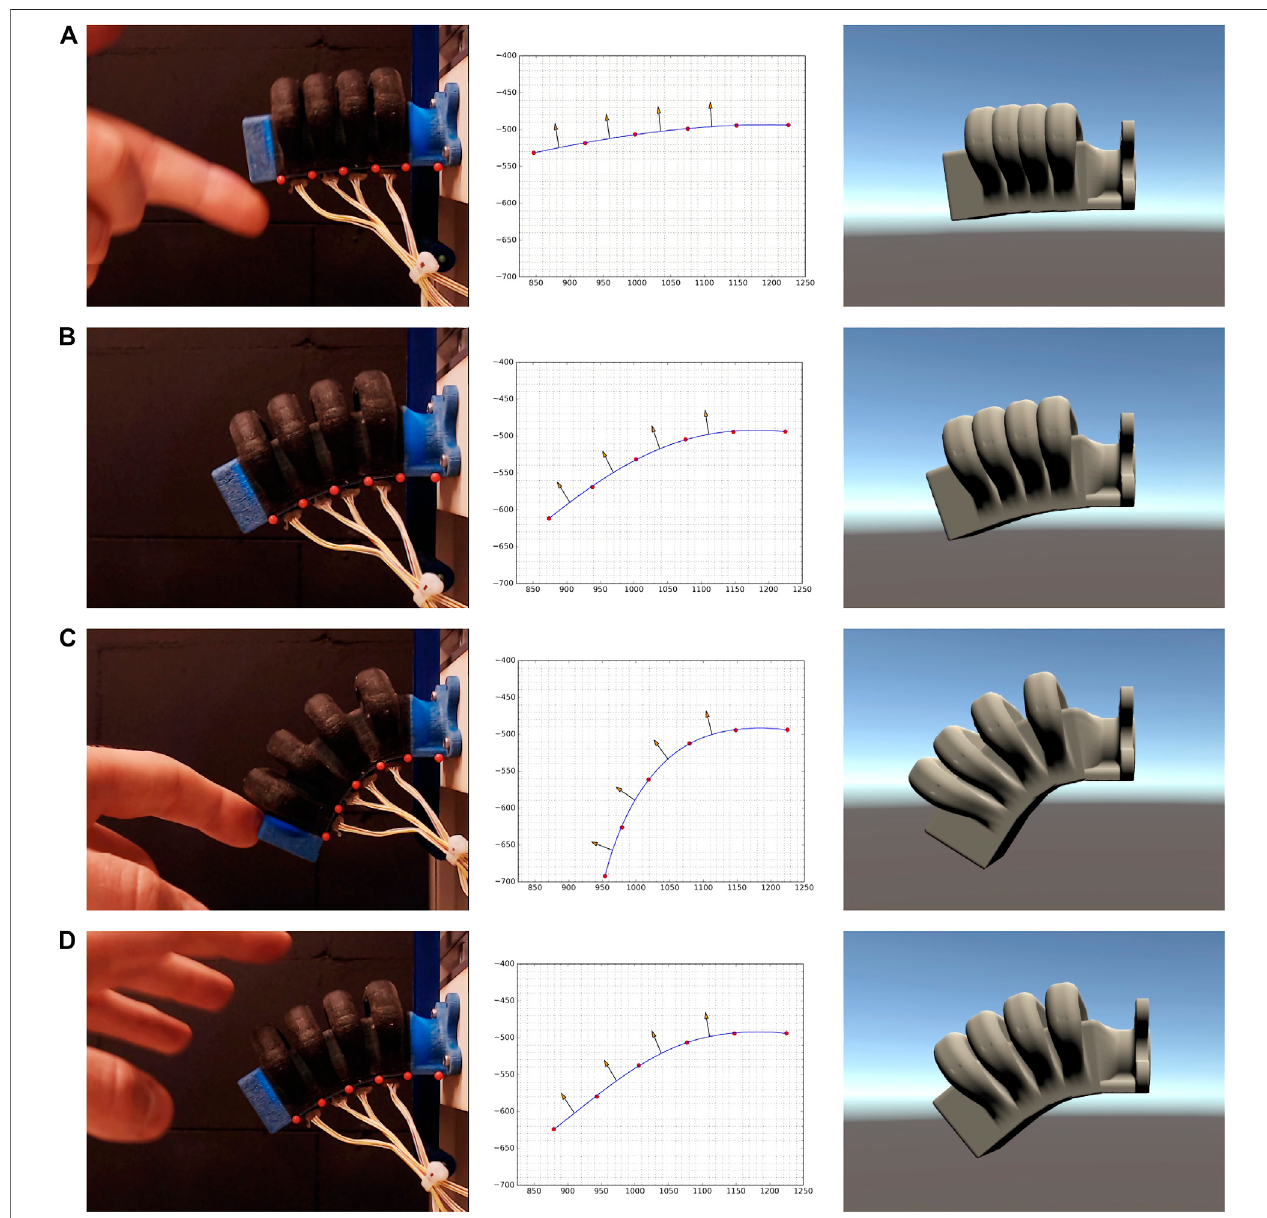
FIGURE7| Demonstrationoftheproposedframeworkforasoftbendingactuator.The fi rstcolumnshowsthesoftactuatorwhiledifferentactuationpressuresand externalforcesarebeingapplied.Thesecondcolumnshowsthemarkercoordinatesthatarepredictedfromthesensormeasurements,andthesplineandbonevectors that are computed from these coordinates. The virtual twin of the soft actuator in the Unity environment is shown in the third column.